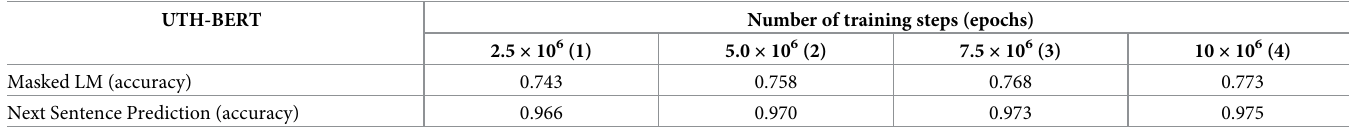
Table 3. Accuracies of Masked-LM and Next Sentence Prediction in pre-training for the evaluation